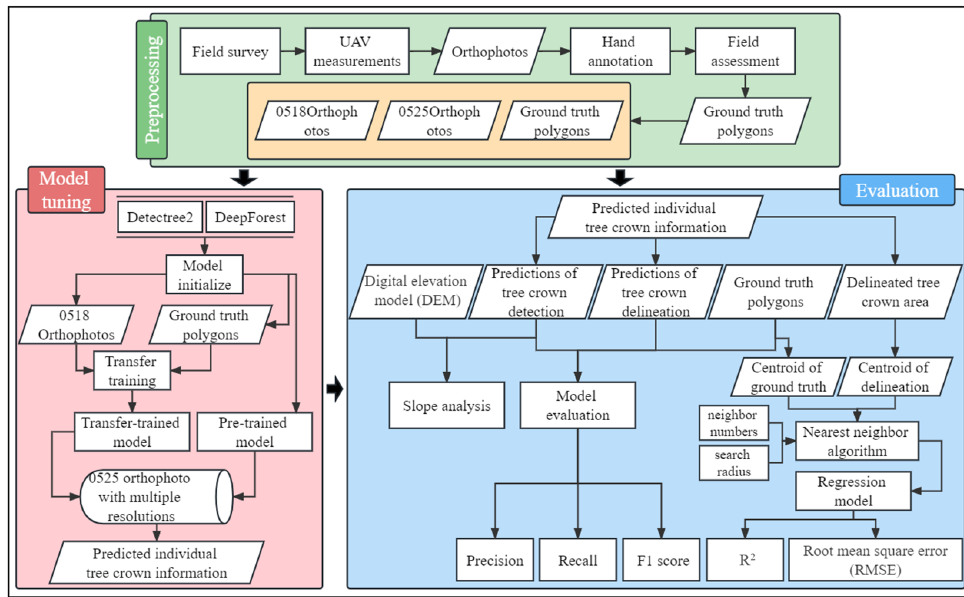
Figure 2. Flowchart of the main steps and analysis for the evaluation of deep-learning-based methods for tree crown detection and delineation.